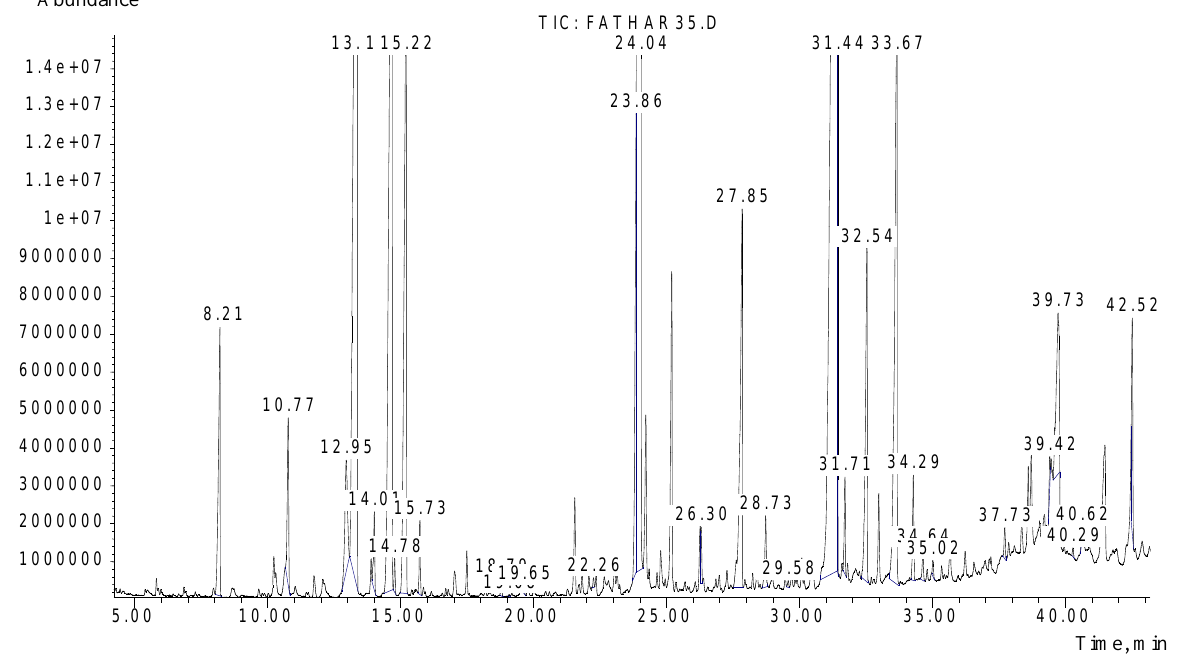
Fig. 2. Chromatographic profile of methyl esters of carboxylic acids of Veronica chamaedrys flowers